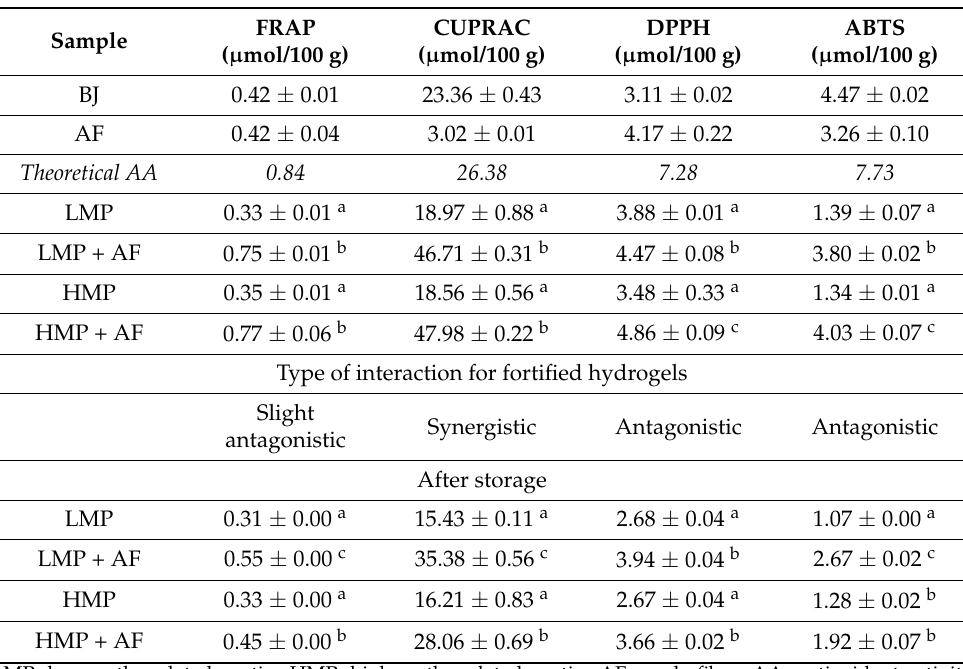
Table 4. Antioxidant activities of blackberry juice, apple fibers and hydrogels (after preparation and after storage).